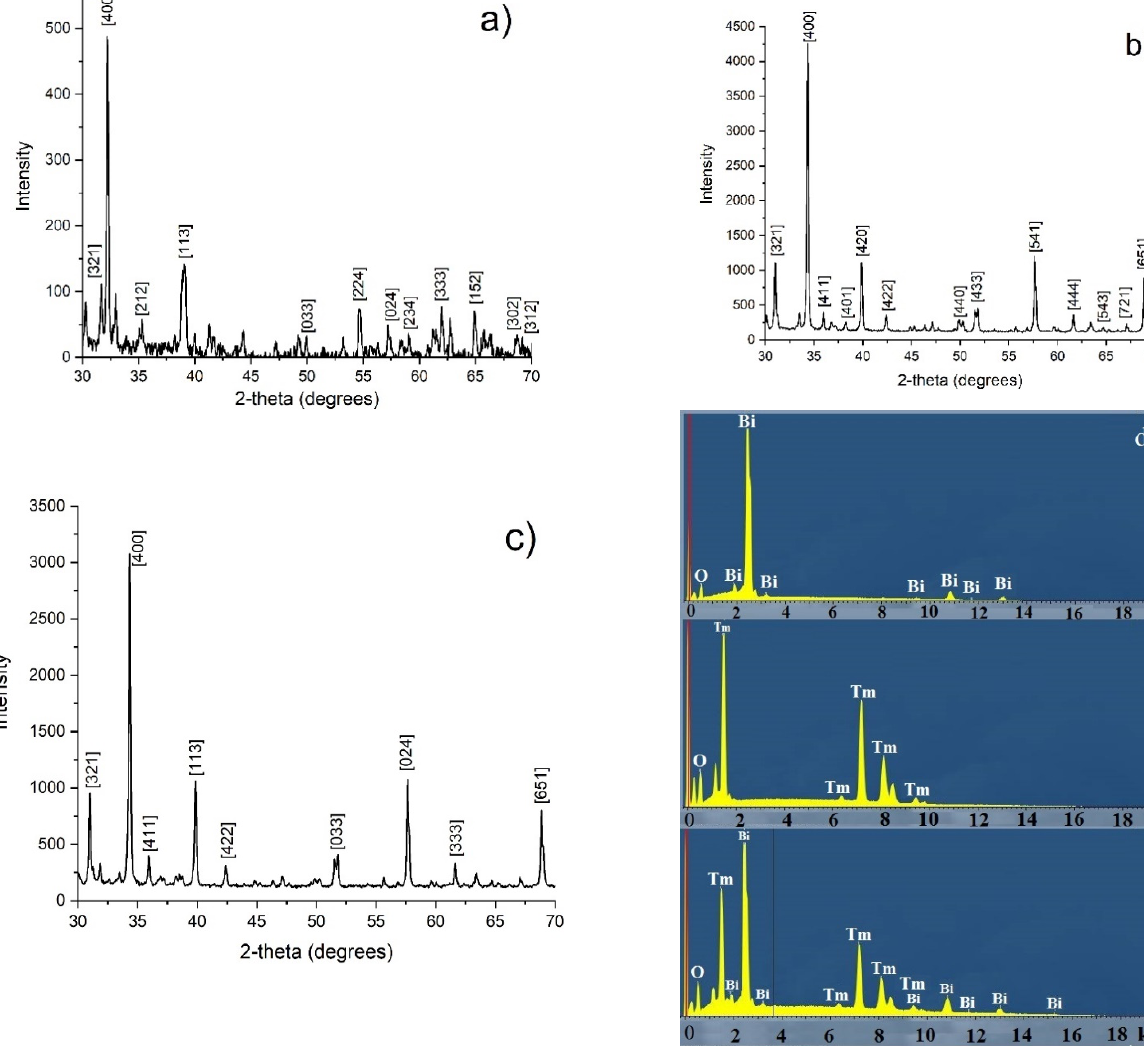
Figure 1. XRD patterns of the oxides Bi 2 O 3 —( a ); Tm 2 O 3 —( b ); Bi 2 O 3/ Tm 2 O 3 (28 at.%)—( c ); EDX analysis with atomic concentrations—( d ).